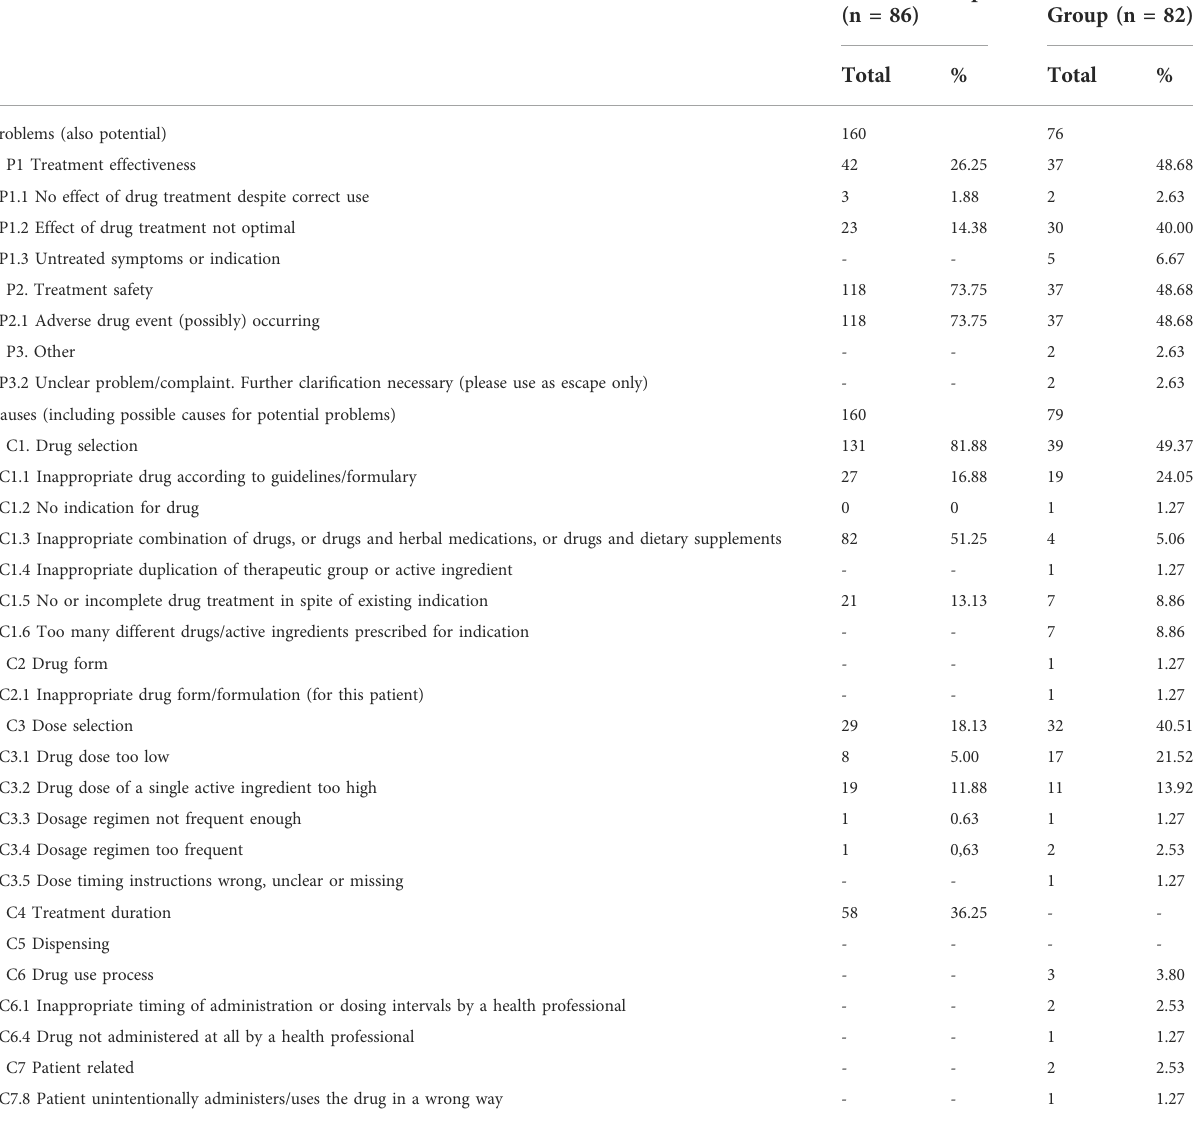
TABLE 4 Main causes of DRPs according to PCNE